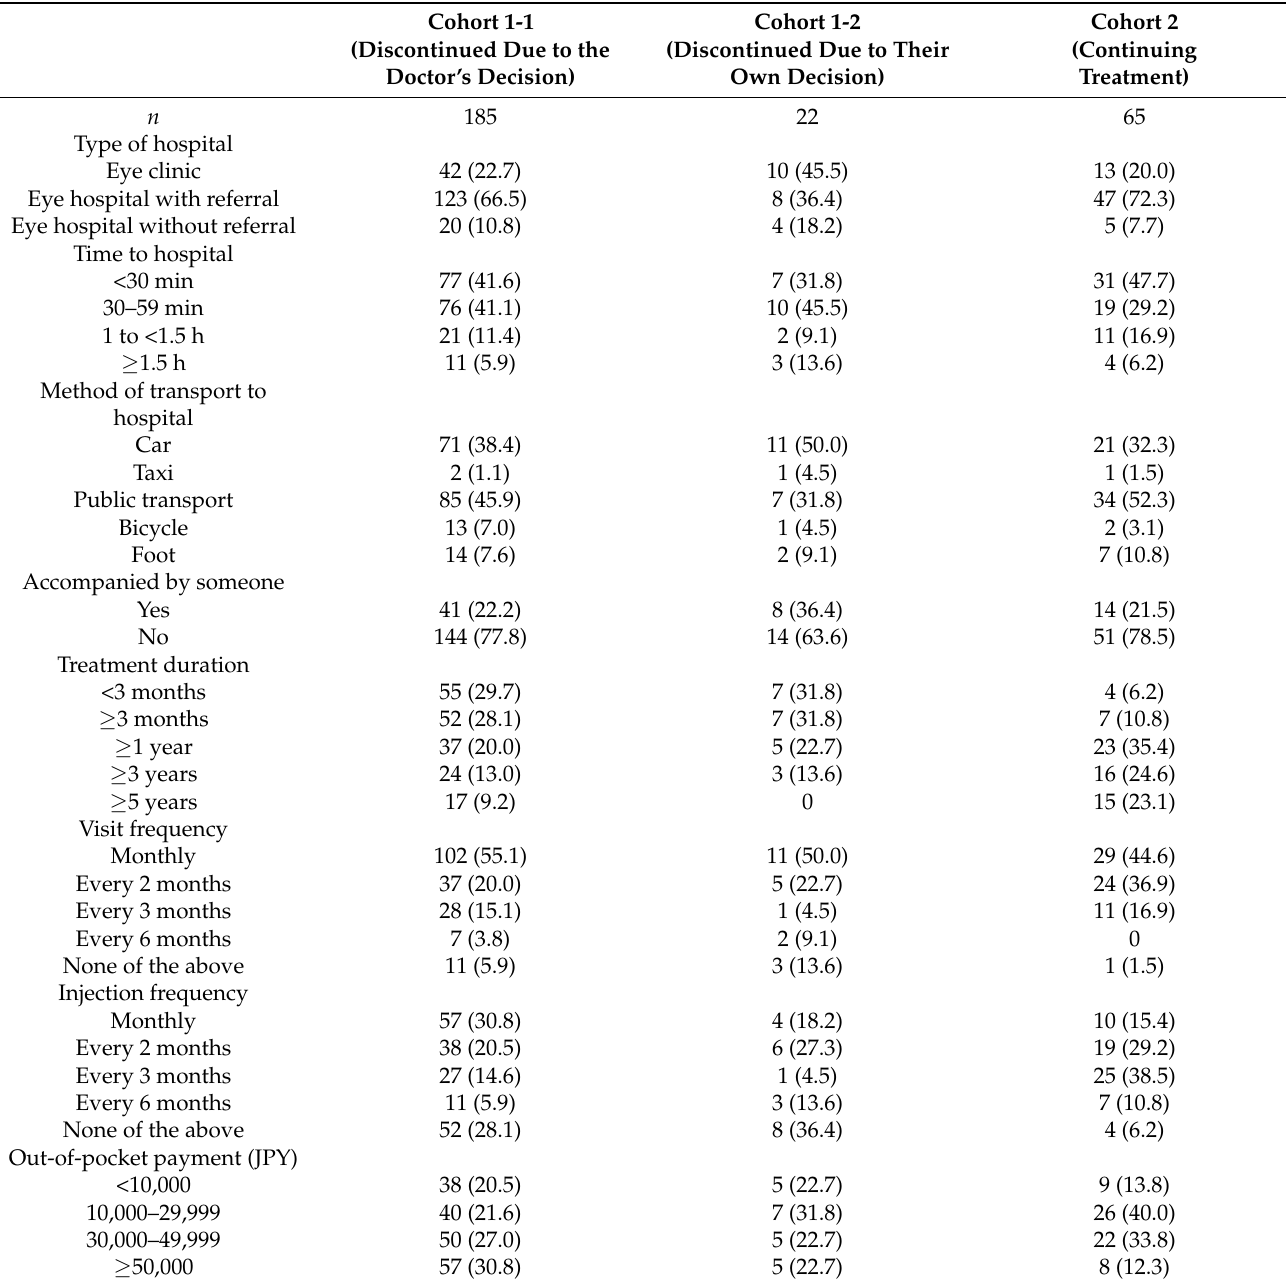
Table 3. History of treatment and knowledge of